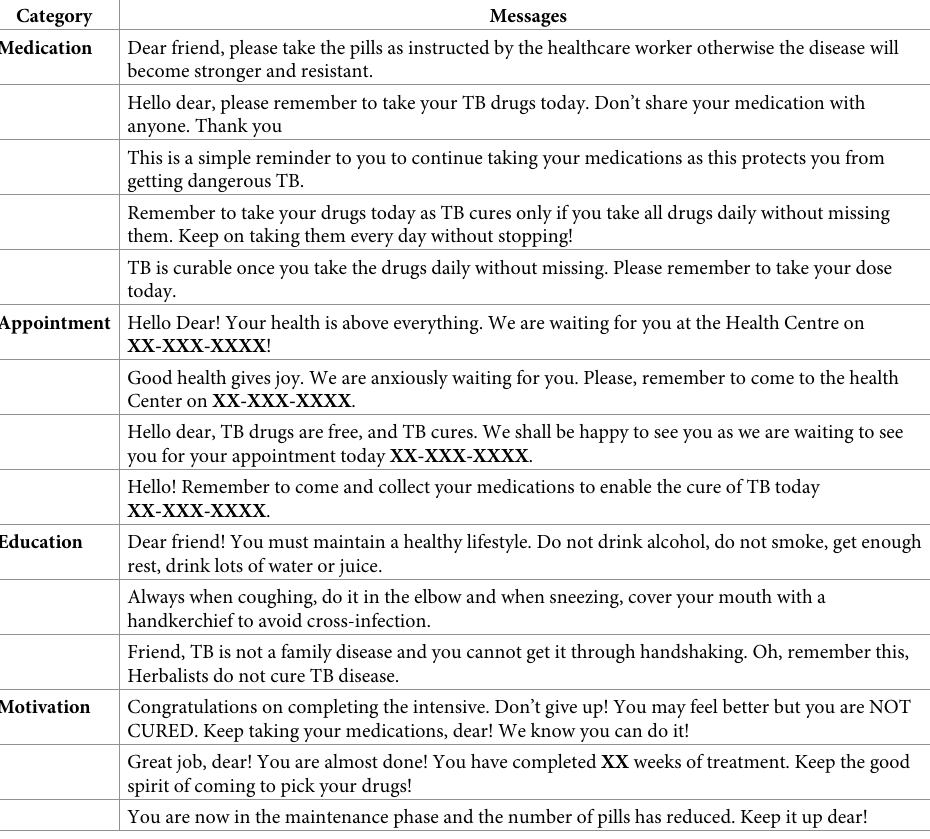
Table 1. Voice-text messages for the different